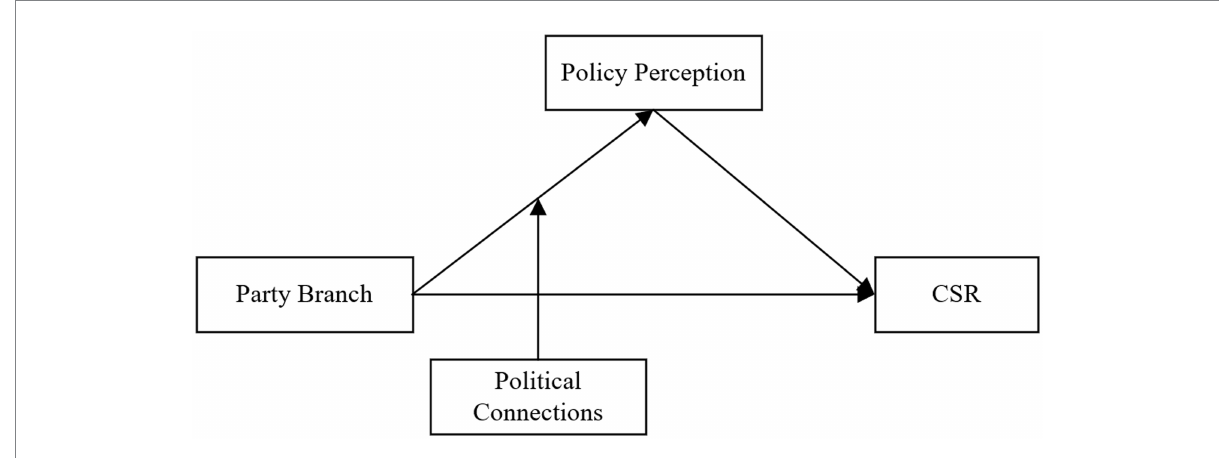
FIGURE 1 Conceptual model.